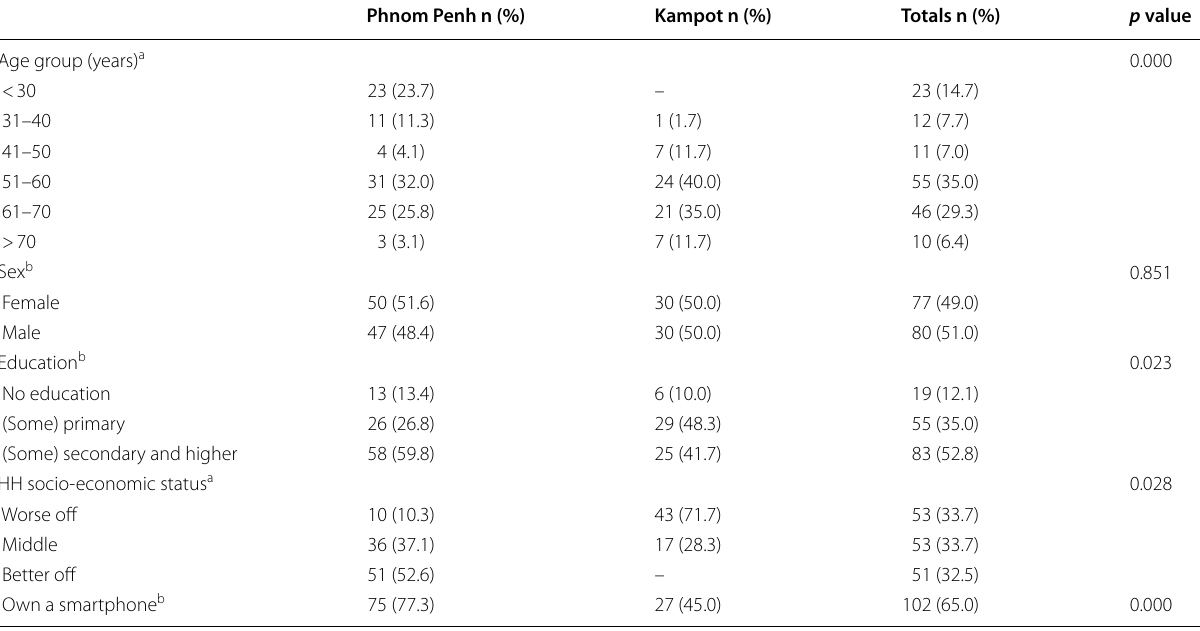
a Fisher’s exact test b Chi